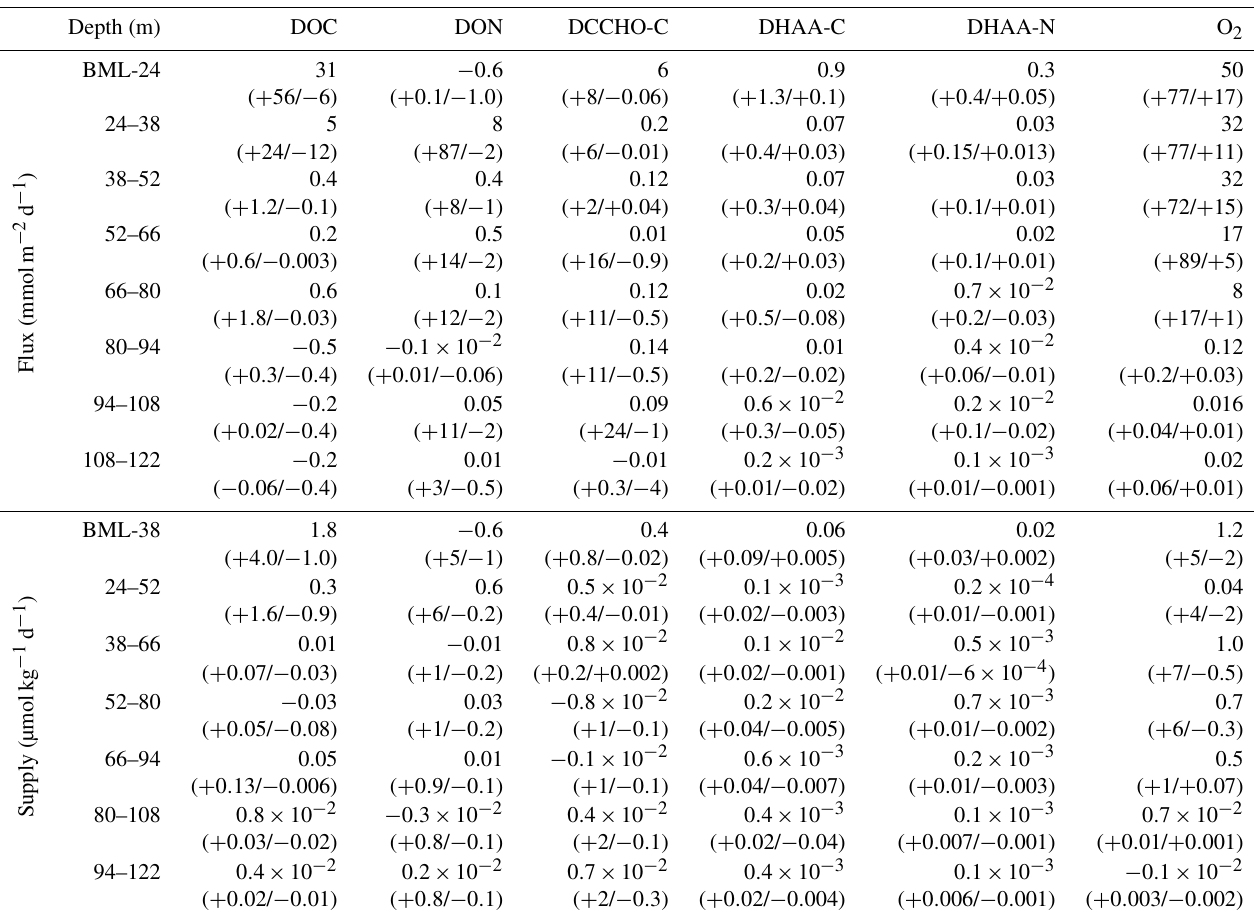
Table 2. Diapycnal fluxes and supplies of O 2 and DOM: DOC, DON, dissolved organic carbon in DCCHO and DHAA and dissolved organic nitrogen in DHAA; 95% confidence intervals, calculated following Schafstall et al. (2010) for each parameter, are presented in brackets. BLM – “below the mixed layer” – a depth, defined below 10m of the water column, using a threshold criterion of 0.2 ◦ C temperature